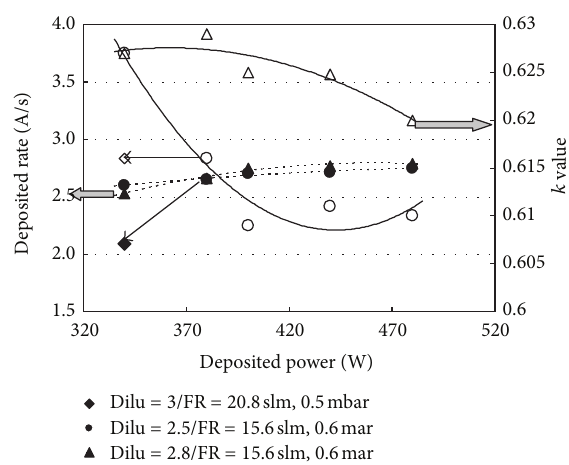
Figure 3: Deposition rate and 𝑘 values as functions of deposition power under three different